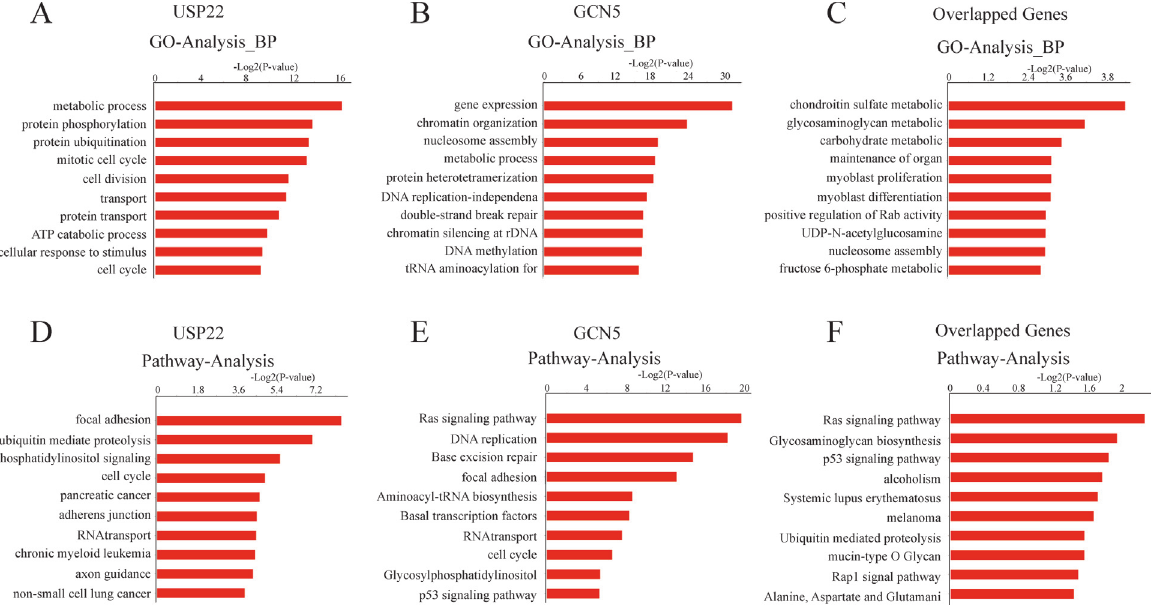
Figure3 -GOcategoryandKEGGpathwayanalysisofthetargetgenesboundbyUPS22andGCN5inHeLacells.(A)GOcategoriesforUSP22binding genes; (B) GO categories for GCN5 binding genes; (C) GO categories for both USP22 and GCN5 binding genes; (D) Pathway analysis of USP22 binding genes; (E.) Pathway analysis of GCN5 binding genes; (F) Pathway analysis of both USP22 and GCN5 binding genes.